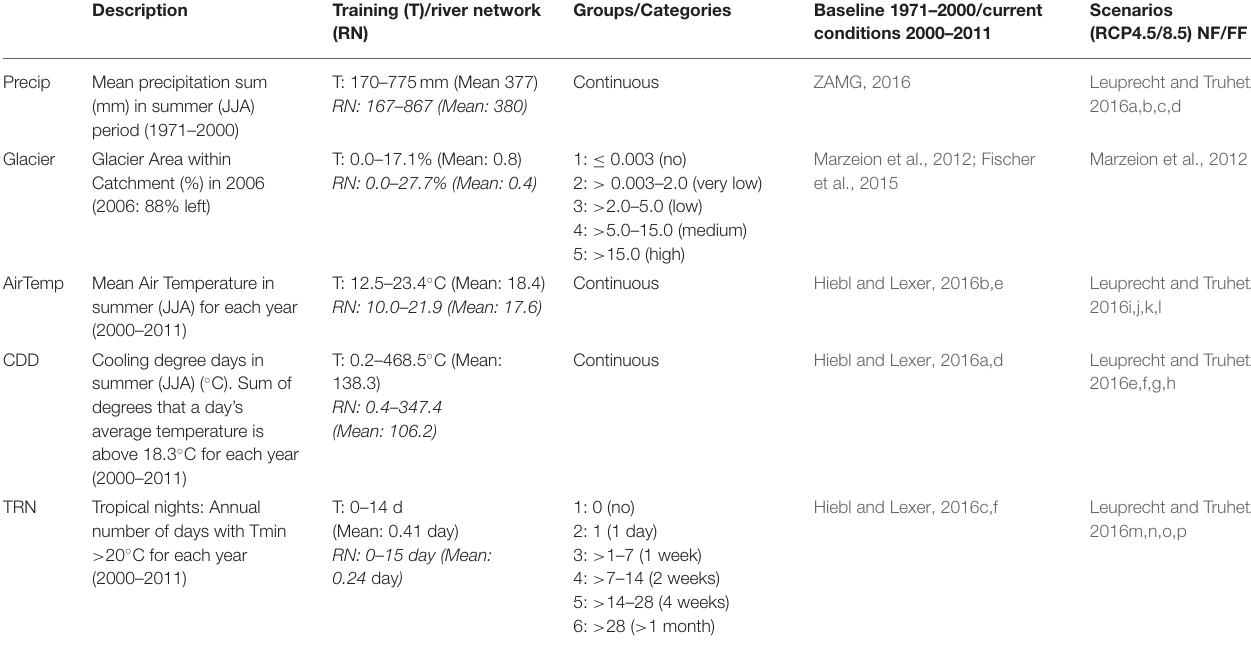
TABLE 2 | Description of independent variables used in the water temperature model that change under climate change scenarios.